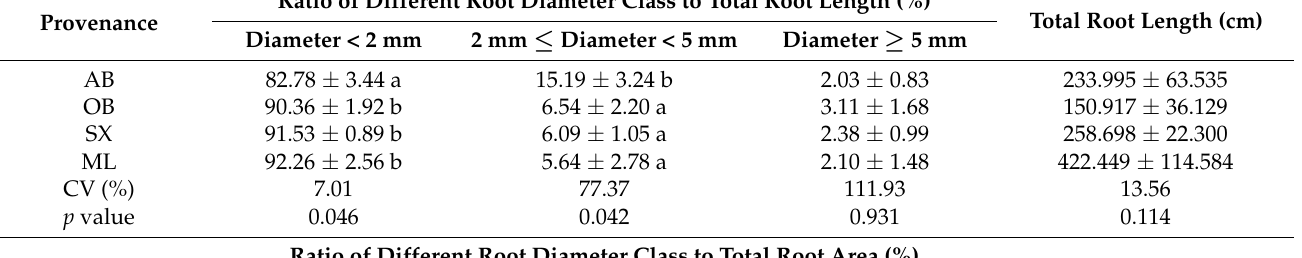
Table 10. Root length, area, and volume ratio of different root diameter class (<2, 2–5, >5 mm) to total root of four provenances of X. sorbifolium